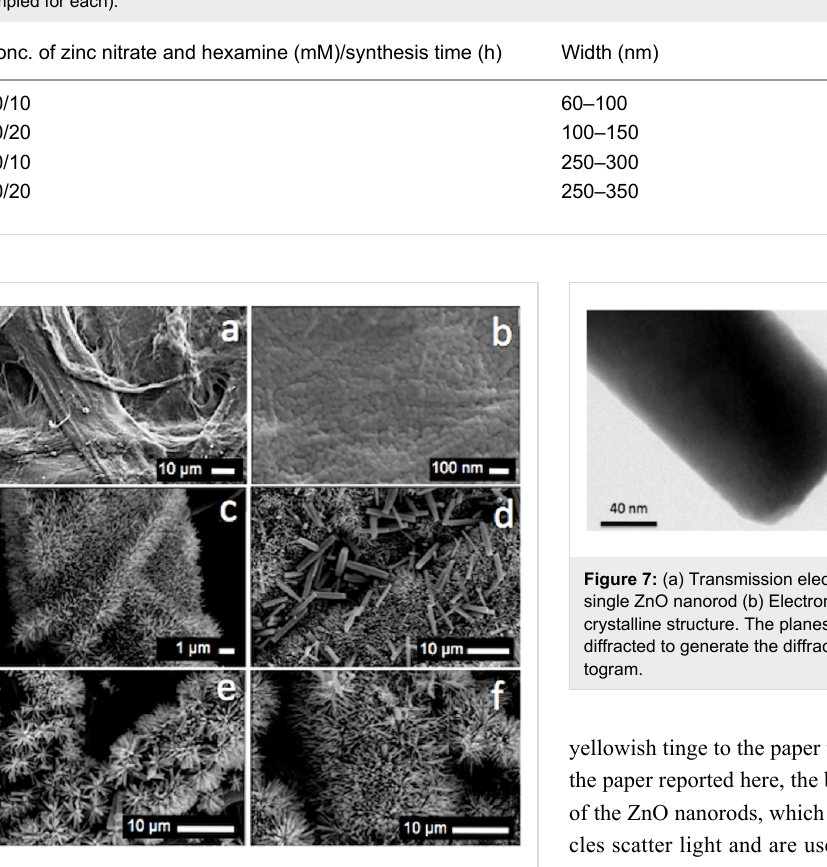
Figure 6: Scanning electron micrographs showing (a) untreated paper handsheet; (b) after seeding with ZnO nanoparticles; (c) ZnO nanorods grown on paper at a concentration of 10 mM for 10 h; (d) ZnO nanorods grown on paper at a concentration of 10 mM for 20 h; (e) ZnO nanorods grown on paper at a concentration of 20 mM for 10 h; and (f) ZnO nanorods grown on paper at a concentration of 20 mM for 20 h.